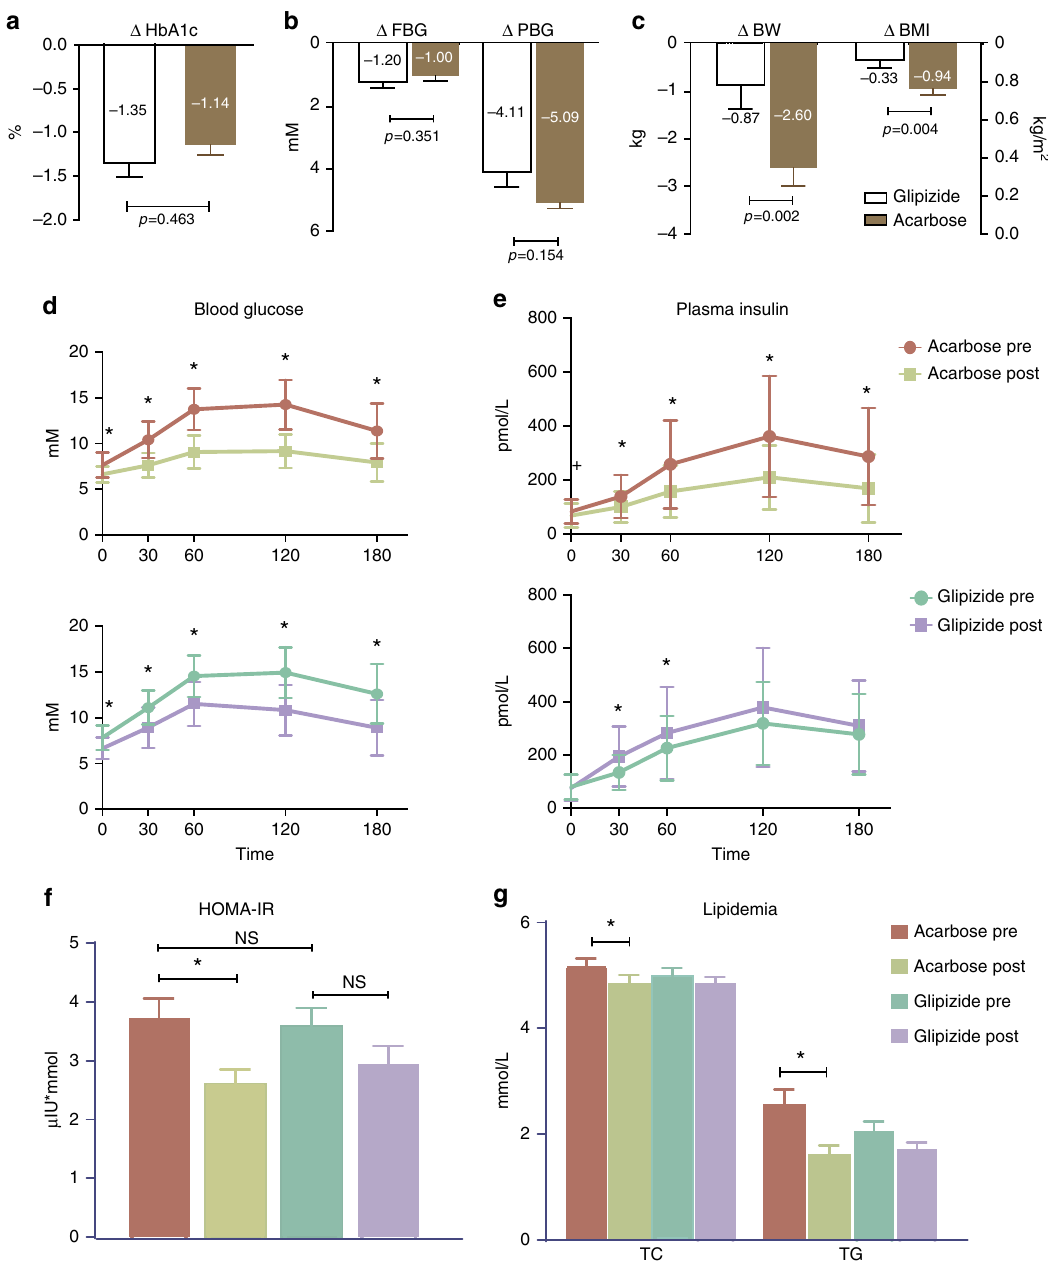
Fig. 1 Major clinical outcomes in patients after 3 months of treatment with Acarbose or Glipizide. a Effect on glycated haemoglobin A1c (HbA1c), in the Acarbose (brown) and Glipizide (white) arms, Wilcoxon rank-sum test. b Effects on fasting blood glucose concentration (FBG), postprandial blood glucose concentration (PBG) in the Acarbose (brown) and Glipizide (white) treatment arms; paired Wilcoxon rank-sum test, * P < 0.01. c Effects on body weight (BW) and body mass index (BMI) in the Acarbose (brown) and Glipizide (white) treatment arms. d Blood glucose excursion curve and e plasma insulin release curve during the meal tests in the two treatment arms, paired Wilcoxon rank-sum test, * P < 0.01, + P < 0.05, pre-treatment vs. post-treatment with Acarbose. f Effects on HOMA-IR, g Total cholesterol (TC) and triglycerides (TG) in the two treatment arms; paired Wilcoxon rank-sum test, * P < 0.01. n